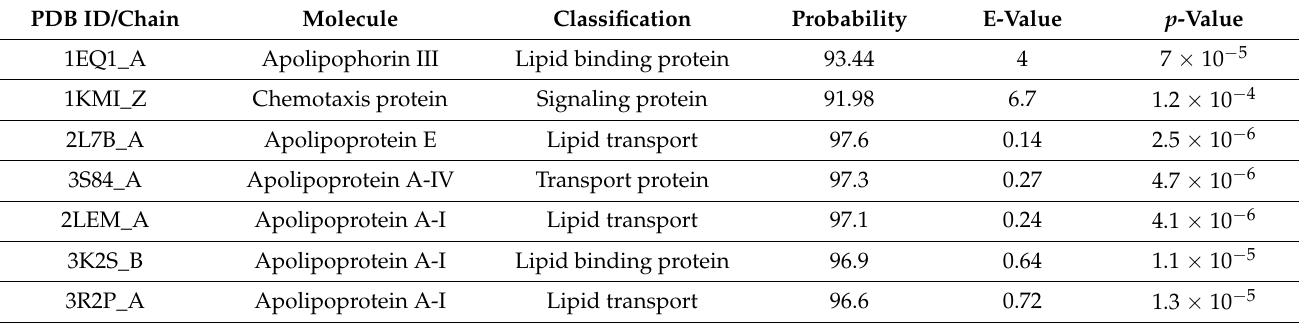
Table 3. Selected homologous templates for subunit V primary model.